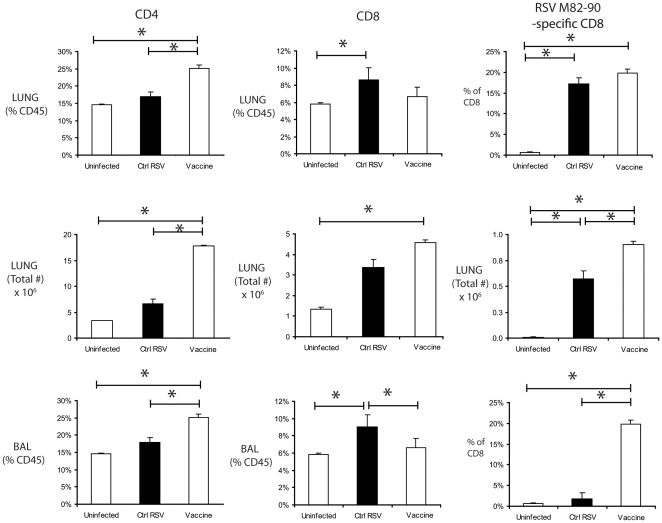
NE-RSV vaccination enhances T cell responses upon live viral challenge.Immunized mice were vaccinated intranasally (i.n.) twice at day 0 and day 28 with NE-RSV (105 PFU equivalent). Control and vaccinated mice were challenged at day 56 (i.n.) with 105 PFU live RSV. The frequency and absolute numbers of total CD4+ T cells, total CD8+ T cells, and RSV M82–90 specific CD8+ T cells in the lungs and bronchoalveolar lavage (BAL) were determined at day 8 post-challenge via flow cytometric analysis of BALs and enzymatically digested lungs. * = p<0.05. Each column represents 5 mice per group, and the experiment was repeated with similar results.